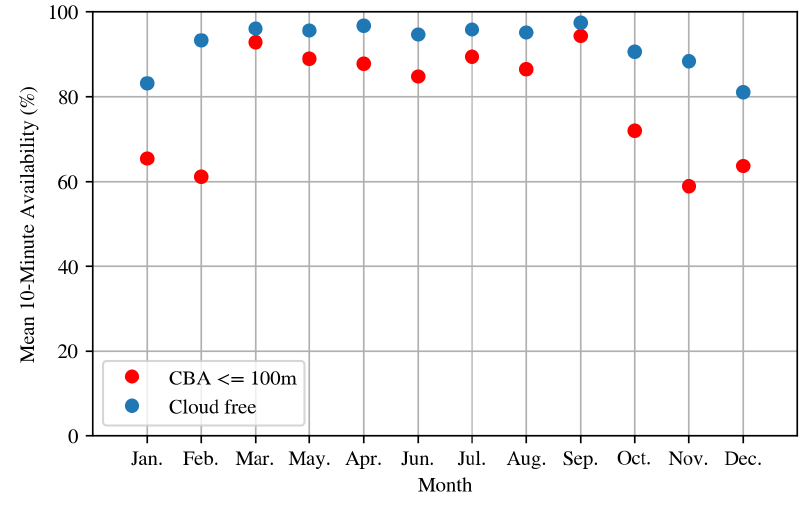
Figure 6. Monthly mean of 10-min availability for the measurement height bin of 152.5m.